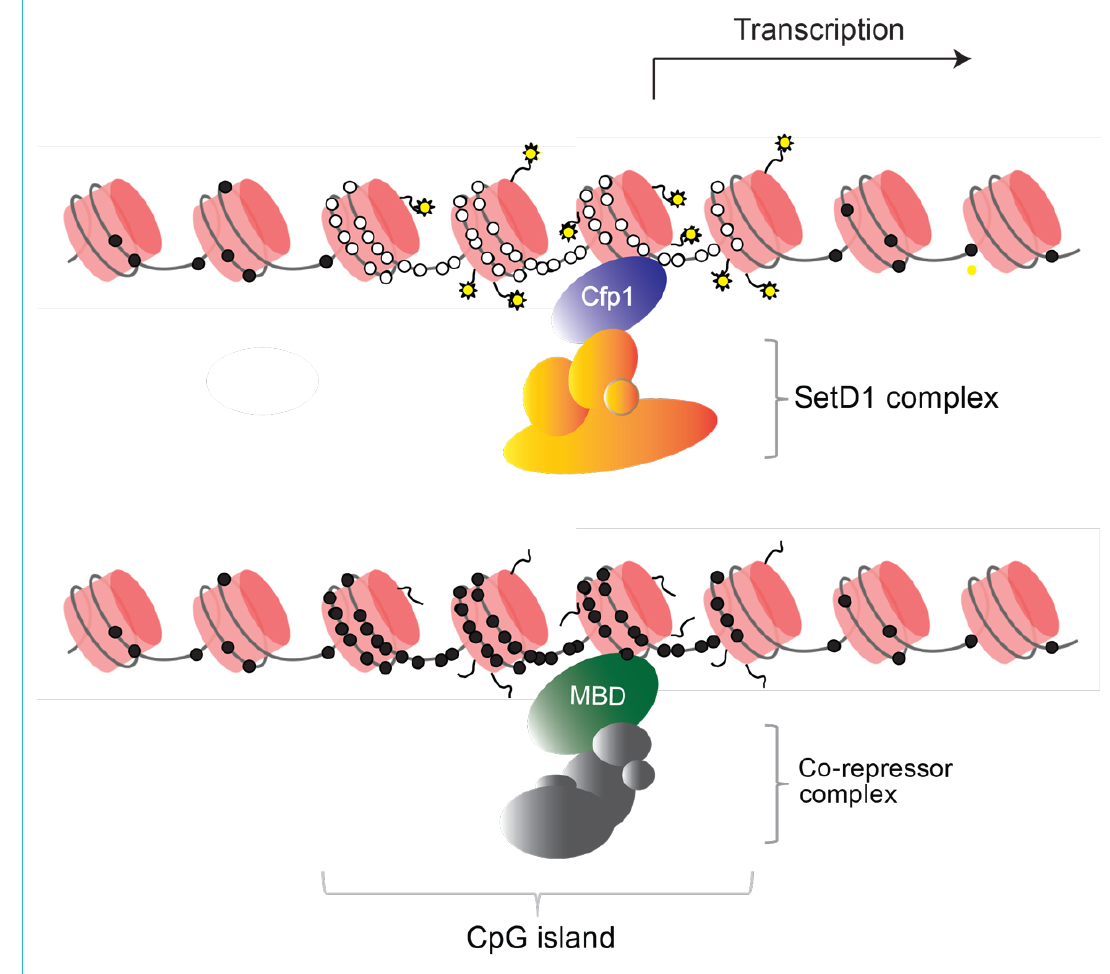
Figure 3: Non-methylated CpG islands recruit “active” histone marks, whereas methylated CpG islands lead to a repressive chromatin struc- ture. CpGs are represented by circles that are either methylated (black) or non-methylated (white) on DNA that is wrapped around nucleo- somes (pink cylinders). The CpG reader Cfp1 targets the SetD1 complex which methylates lysine 4 of histone H3. Other CpG readers also re- cruit “active” chromatin modifiers. MBD proteins bind methylated CpG, either in methylated CpG islands or elsewhere in the genome and recruit histone deacetylase complexes that inhibit